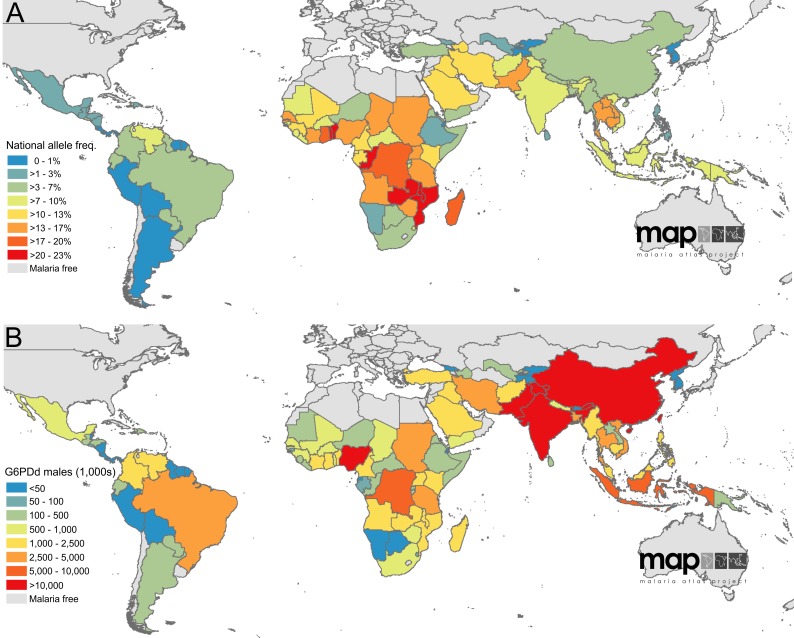
Population-weighted areal estimates of national G6PDd prevalence predictions.(A) summarises national-level allele frequencies, while (B) displays national-level population estimates of G6PDd males. Values are in thousands.